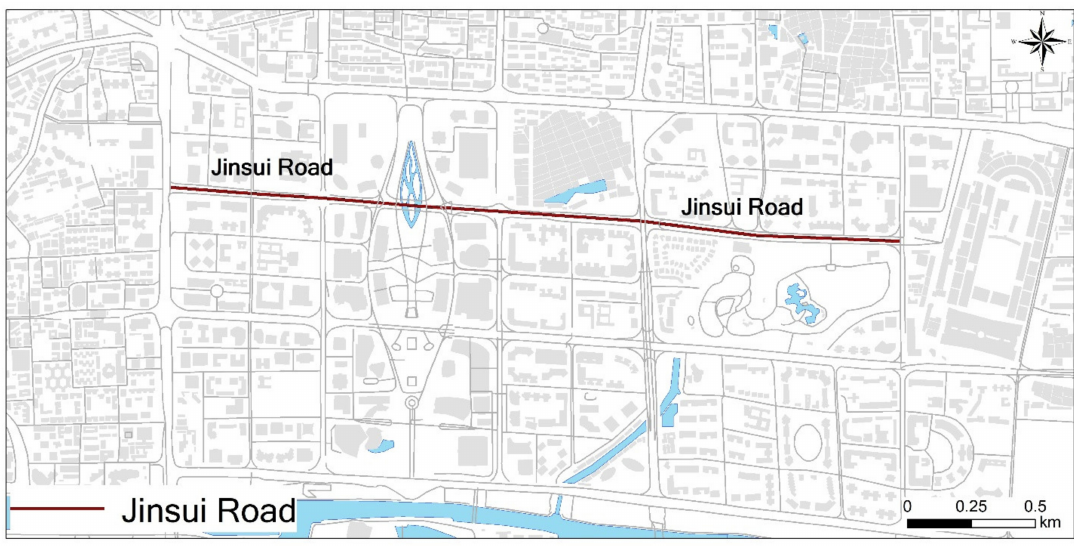
Figure 10. Jinsiu